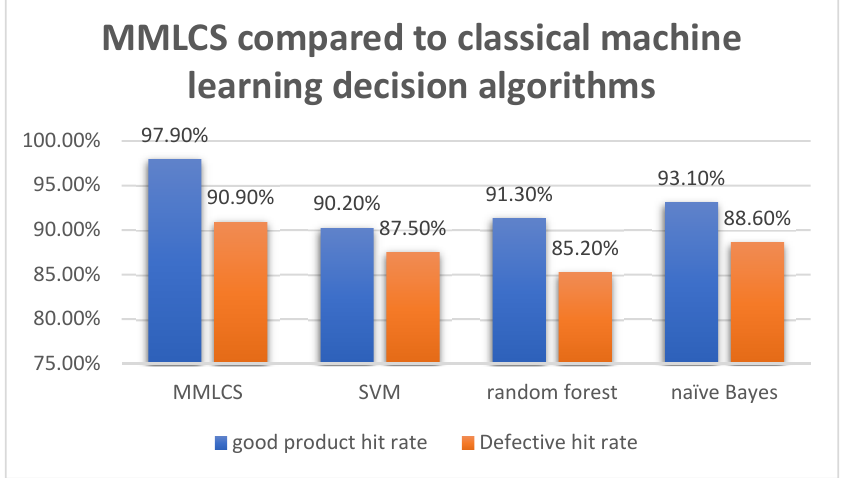
Figure 6. MMLCS compared to classical machine learning decision algorithms.